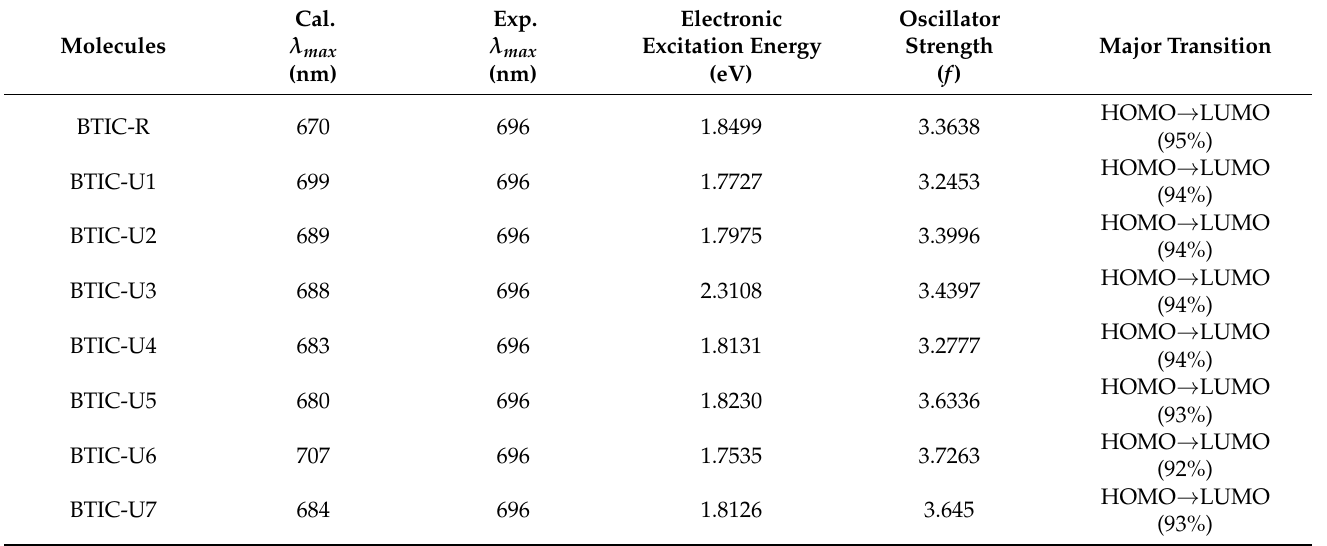
Table 2. Gas phase computed transition character, oscillator strength (ƒ), transition energy